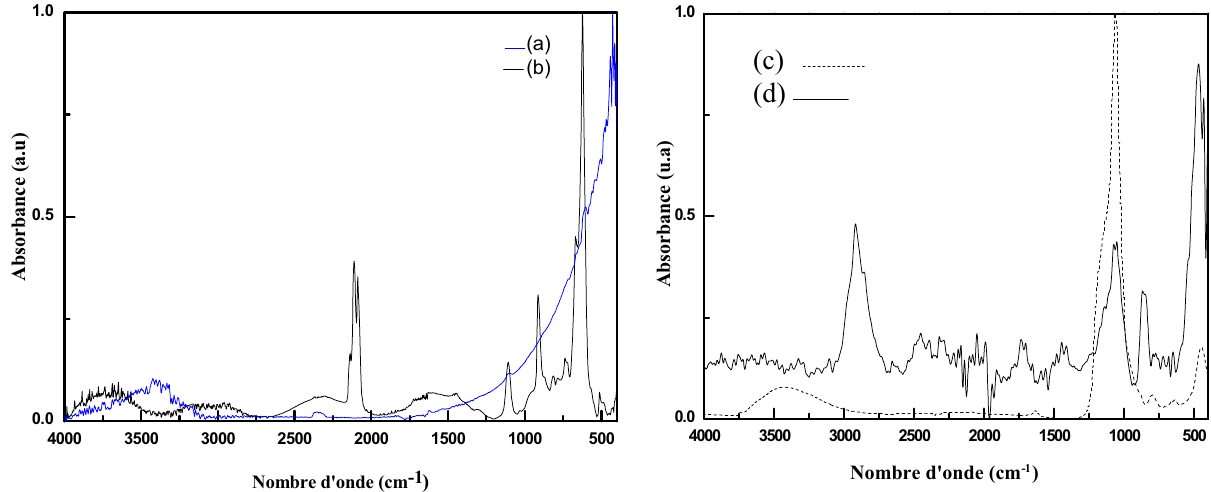
Figure 2: FTIR spectra of ( a ) Si, ( b ) PSi, ( c ) oxide PSi, and ( c ) PTh/oxide